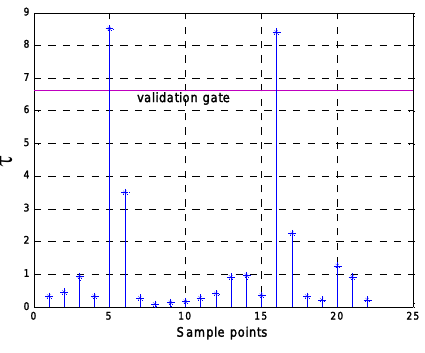
Fig. 7. Innovation